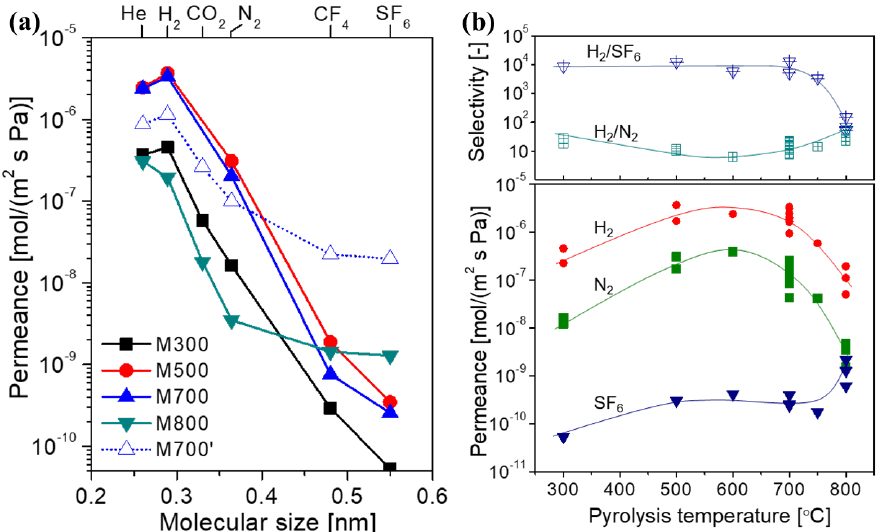
Figure 21. ( a ) Single-gas permeance at 200 °C for AHPCS-derived membranes pyrolyzed at different temperatures (M700 was derived from the parent AHPCS solution, while M70 0′ was derived from the pre-cross-linked AHPCS solution); ( b ) relationship between the gas permeation performance and pyrolysis temperature. Adapted from [73] with permission from Elsevier.